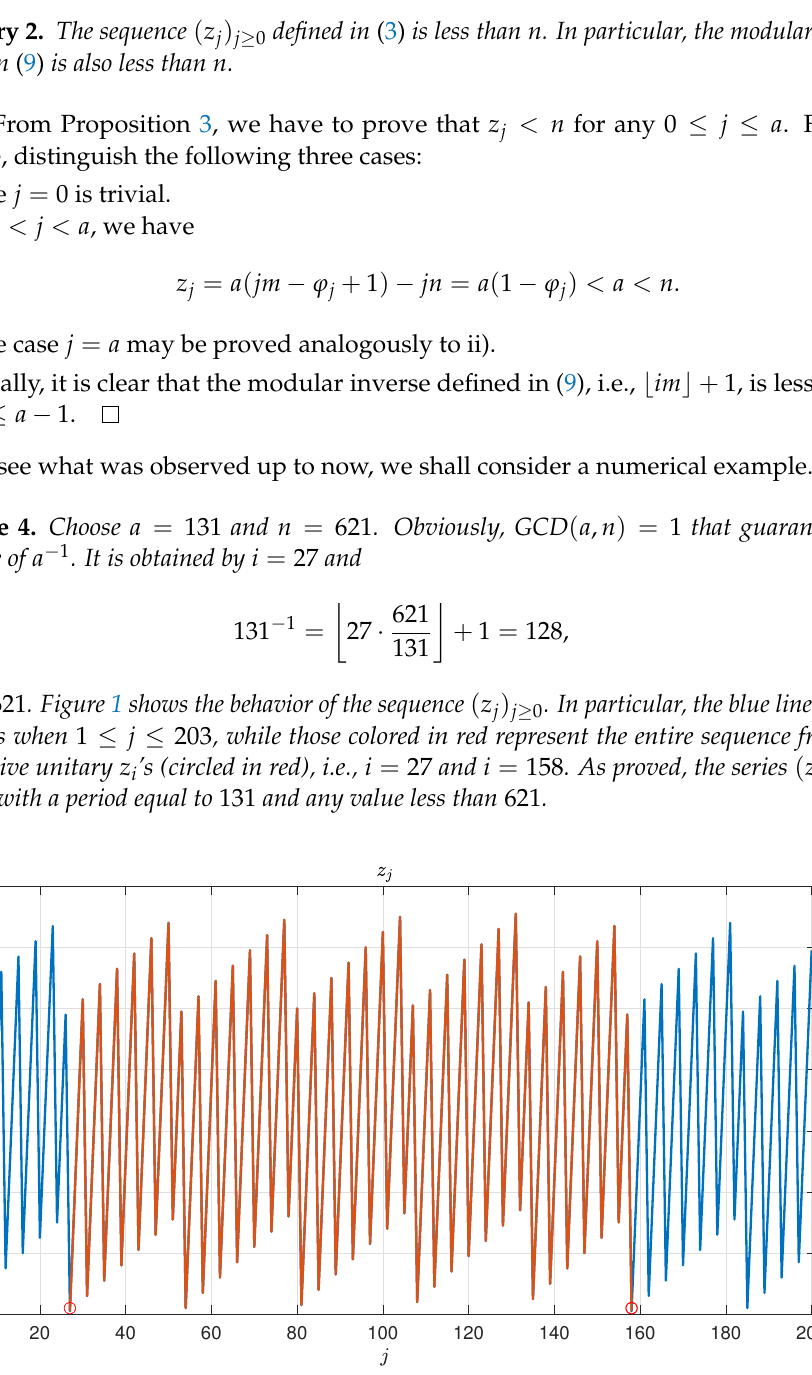
Figure 1. Sequence ( z j ) 1 ≤ j ≤ 203 when a = 131 and n = 621. The red line highlights the entire sequence ( z ) j j ≥ 1 between two consecutive unitary z i ’s (red